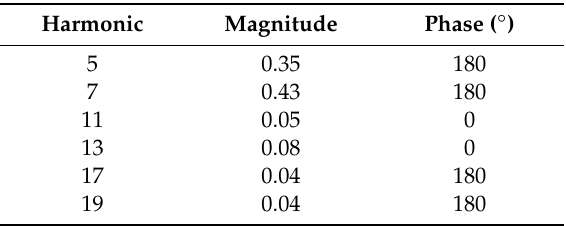
Table 2. Harmonic spectrum of nonlinear